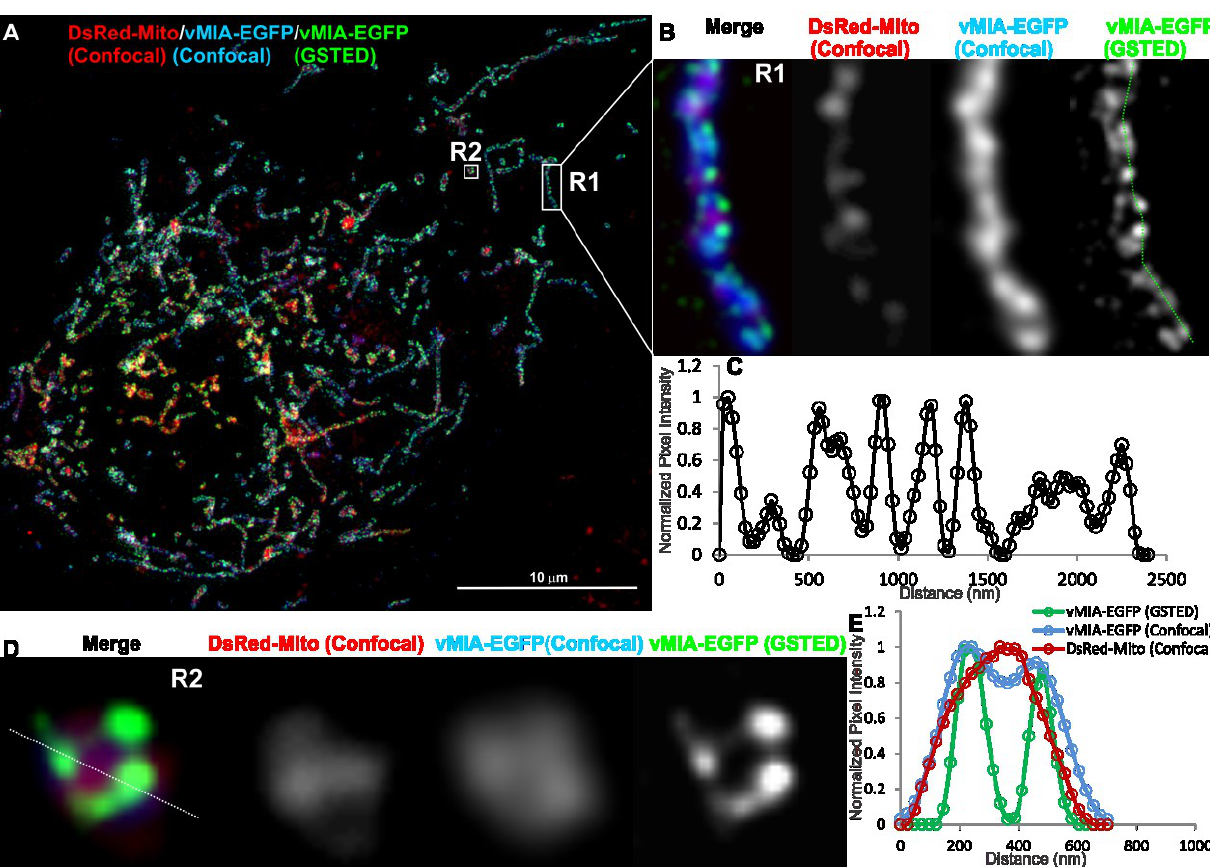
Figure 5. Gated stimulated emission depletion (GSTED) microscopy of vMIA-EGFP in human fibroblasts. ( A ) HFFs were lipofected with vectors expressing vMIA-EGFP and DsRed-Mito. At 24 hours post transfection, cells were methanol fixed as described as below and elsewhere [23] and imaged using GSTED (vMIA-EGFP) and confocal microscopy (DsRed-Mito, vMIA-EGFP) followed by deconvolution of both the images. ( B ) Zoomed, merged image of a tubular mitochondrion in the boxed region (R1) is shown. This includes DsRed-Mito confocal (red), vMIA-EGFP confocal (blue) and vMIA-EGFP GSTED (green). Each channel is also presented individually. ( C ) Intensity profile of the pixels marked by the dotted line on the GSTED panel demonstrates the clustered distribution of vMIA along the entire length of the OMM of this mitochondrion. ( D ) The zoomed, merged image of a mitochondrion in the boxed region (R2) is shown. ( E ) The normalized intensity profile along the line shown on the R2 image, which demonstrates the significant improvement in visualizing the vMIA distribution along OMM by GSTED as compared to confocal imaging and its improved resolution of its localization away from the matrix and at the OMM. For higher resolution images, see Supplemental Figure